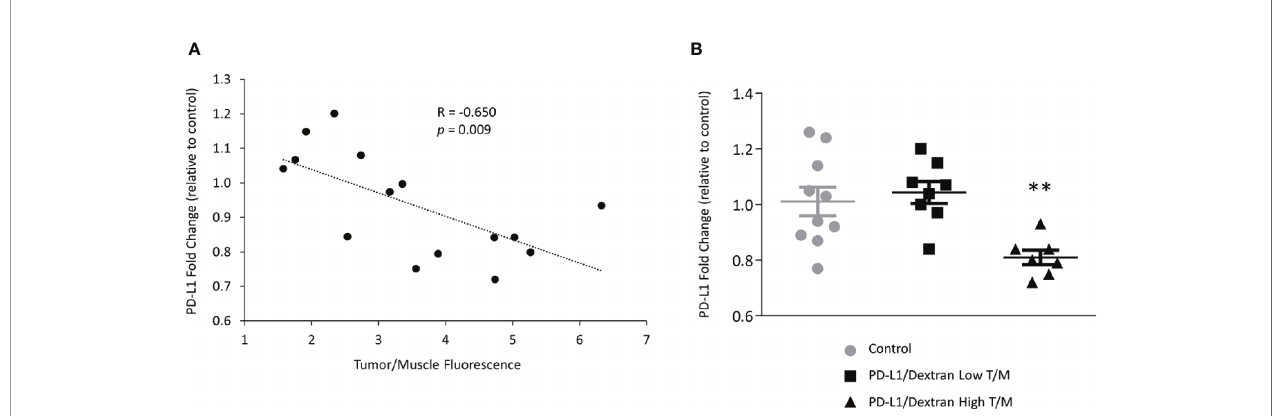
FIGURE 5 | In vivo downregulation of PD-L1 in MDA-MB-231 tumors treated with PD-L1 siRNA dextran. (A) Correlation between the levels of PD-L1 mRNA, represented by PD-L1 fold change relative to control tumors, and the tumor/muscle fl uorescence ratio in tumors treated with PD-L1 siRNA dextran NPs. (B) Relative fold change of PD-L1 mRNA expression in MDA-MB-231 tumors treated with the PD-L1 siRNA dextran NPs. Mice were injected with PBS, or PD-L1 siRNA dextran NPs through the tail vein. Animals were divided, according to the tumor to muscle fl uorescence ratio measured in vivo , into the highest (triangles) and lowest (squares) 50% values. Fold changes were normalized to tumors treated with PBS. Lines represent Mean ± Standard Error of the Mean. **p < 0.01 compared to control tumors or low tumor to muscle fl uorescence ratio tumors.